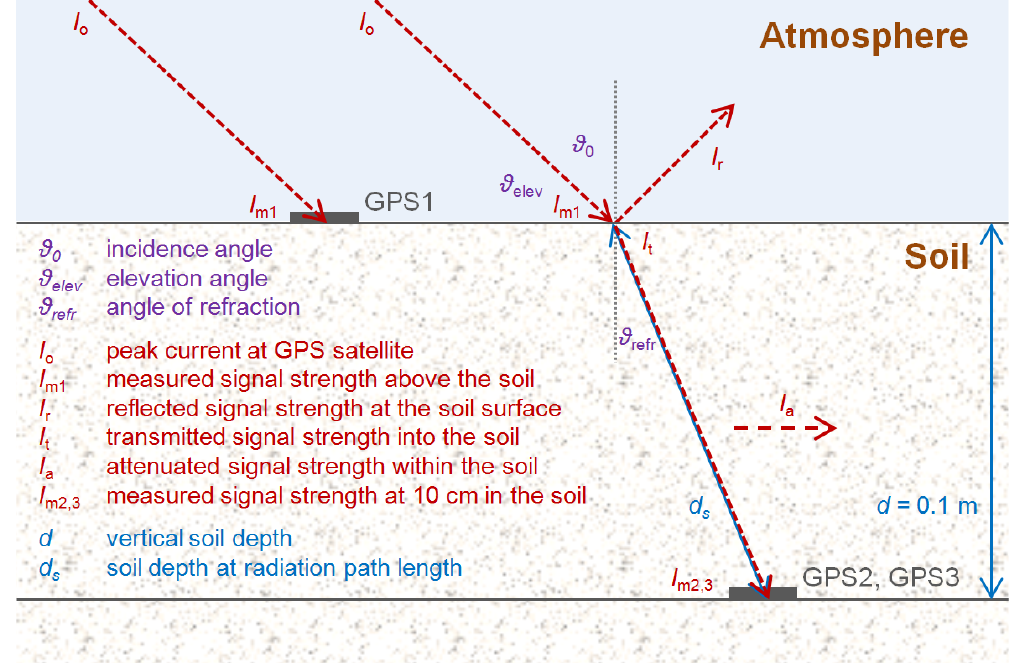
Figure 3. Overview of influences on the measured GPS intensity and radiation path length through the soil column, as well as the angle changes due to reflection, refraction and attenuation processes according to Koch et al. [37]. Only the direct signal paths are shown for one satellite at a specific elevation (in red ).